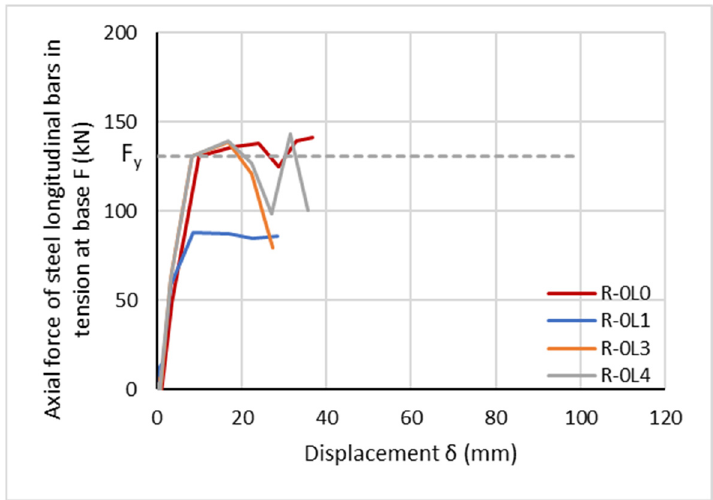
Figure 4. Comparative F- δ curves of unretrofitted